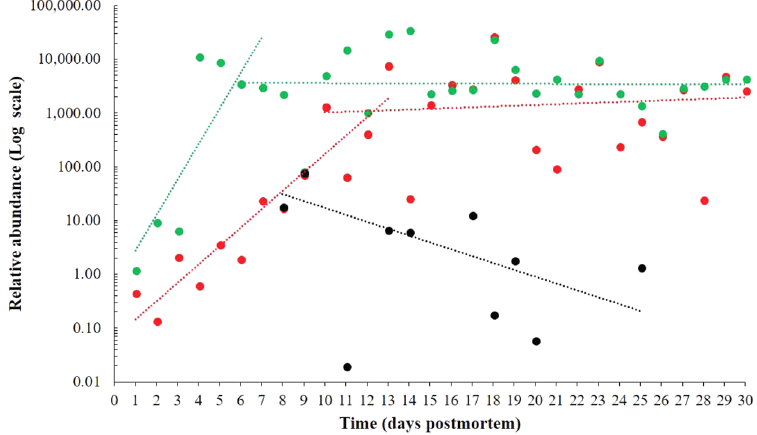
Figure 8. Relative abundance of Firmicutes species as a function of the postmortem time. Enterococcus faecalis (March – red; June – green), Clostridium paraputrificum (March – black). Logarithmic scale representing number of bacterial